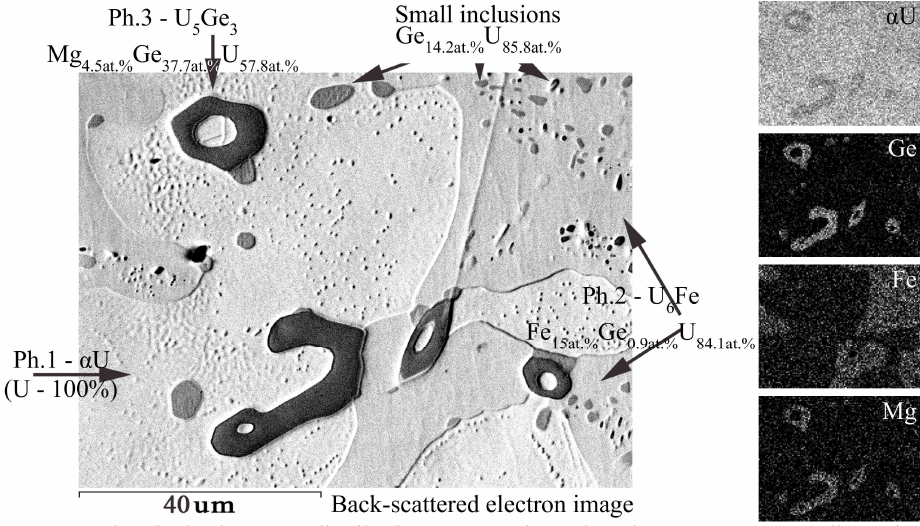
Fig. 2. Chemical elements distribution maps given by the x-ray energy dispersive